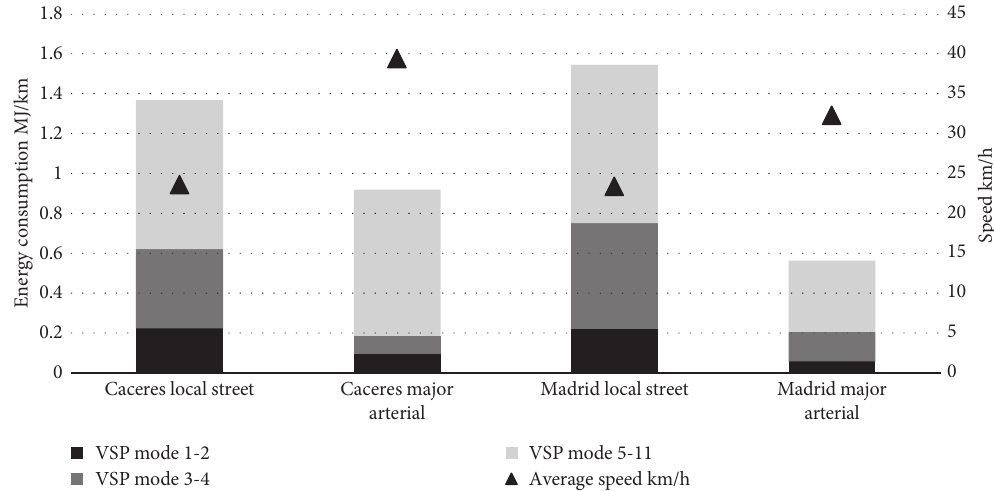
Figure 6: Average energy consumption (MJ/km) and average speed (km/h) for each city and type of road.